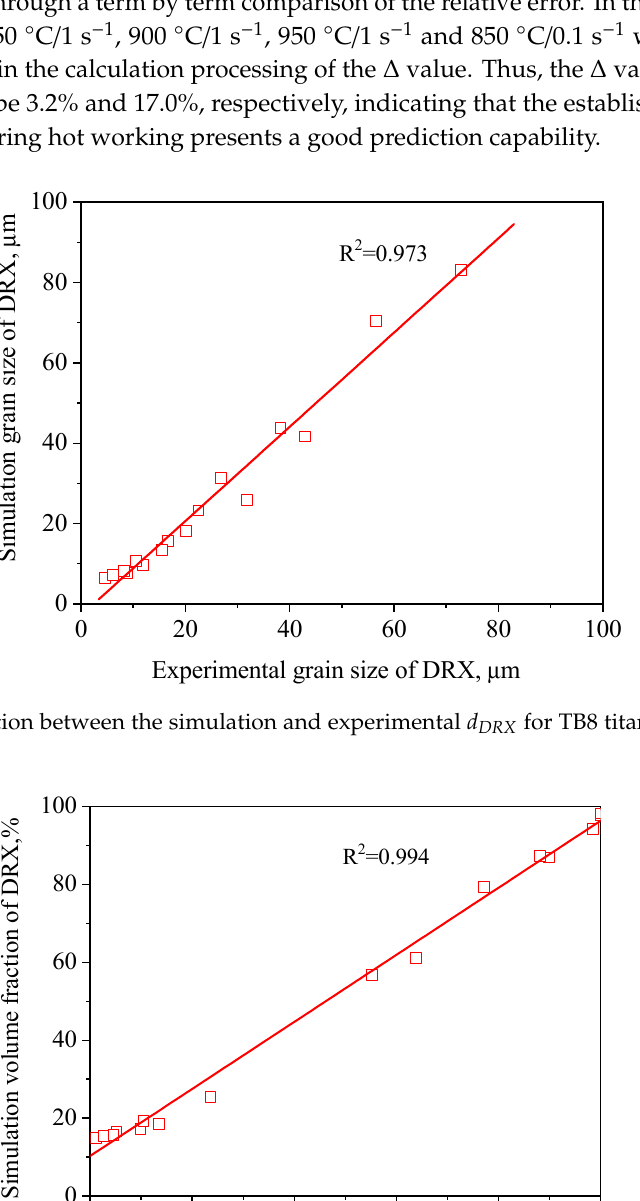
Figure 20. Correlation between the simulation and experimental X DRX for TB8 titanium alloys after hot deformation.